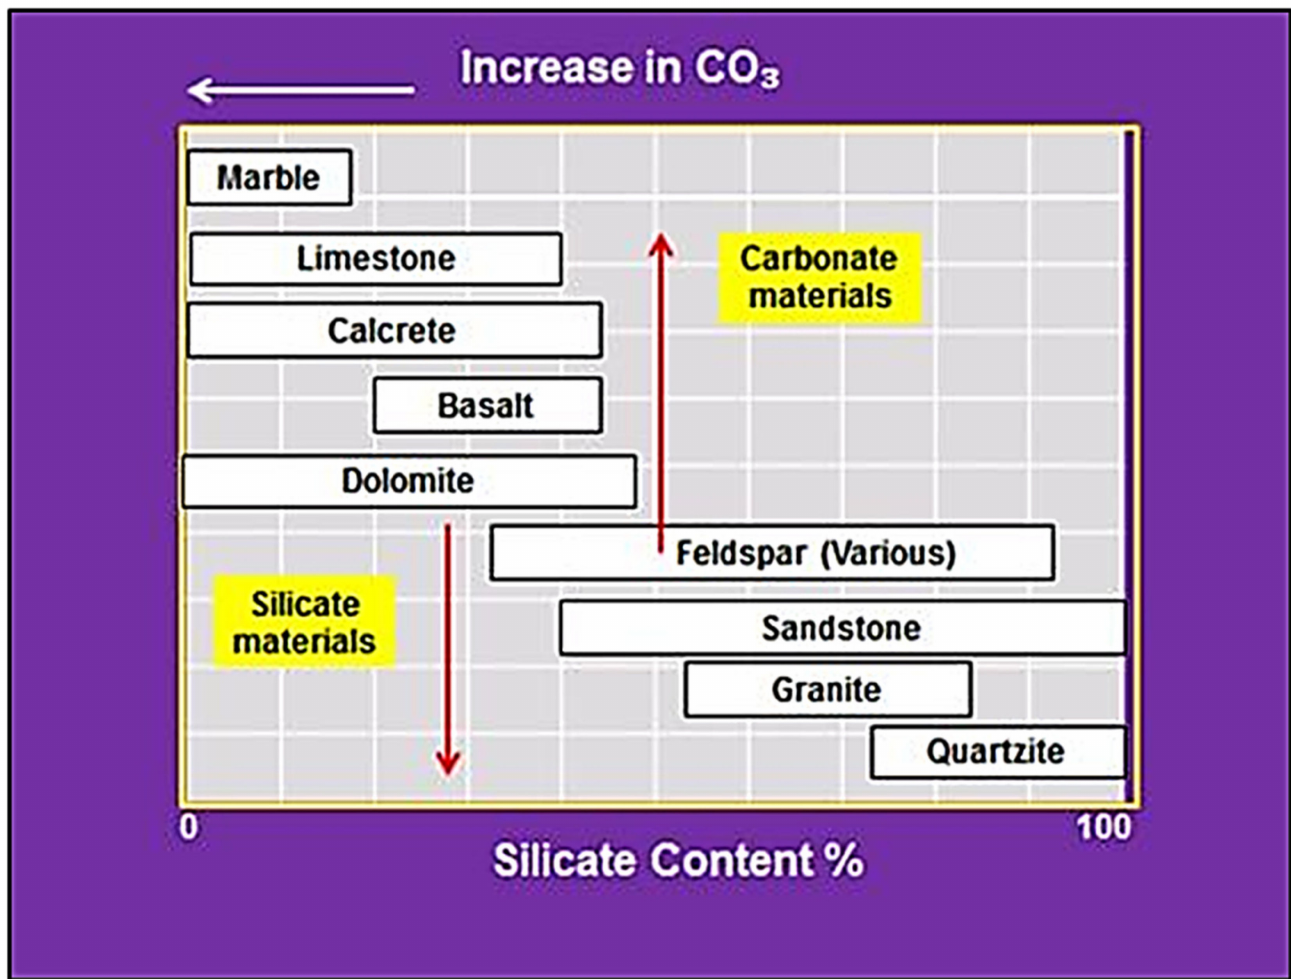
Figure 3. Silicon content variation versus Carbon-dioxide content found in some typical and commonly known naturally available